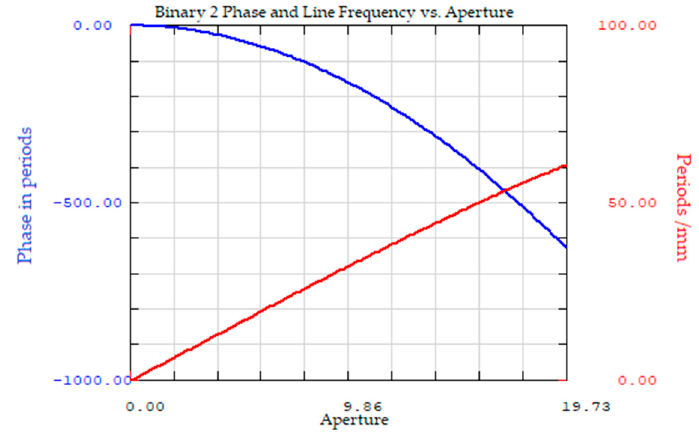
Figure 5. Phase plot and the line frequency versus aperture for DOE.